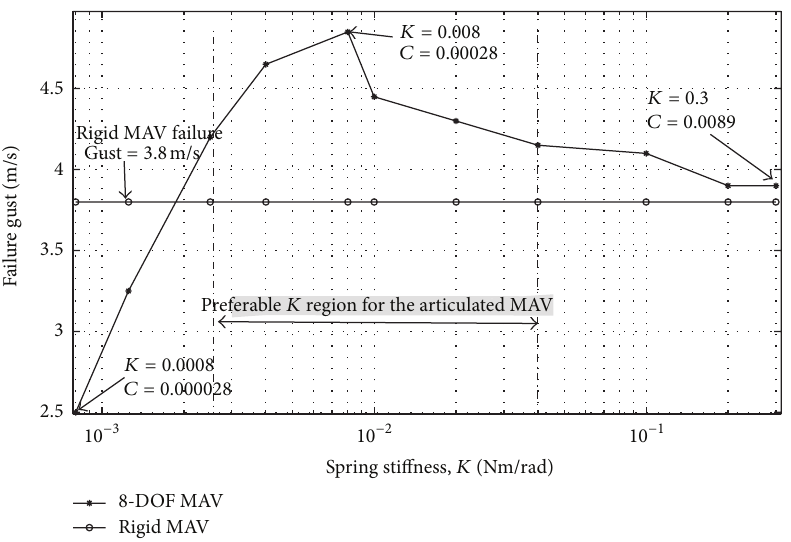
Figure 13: Maximum allowable crosswind gust versus joint spring stiffness